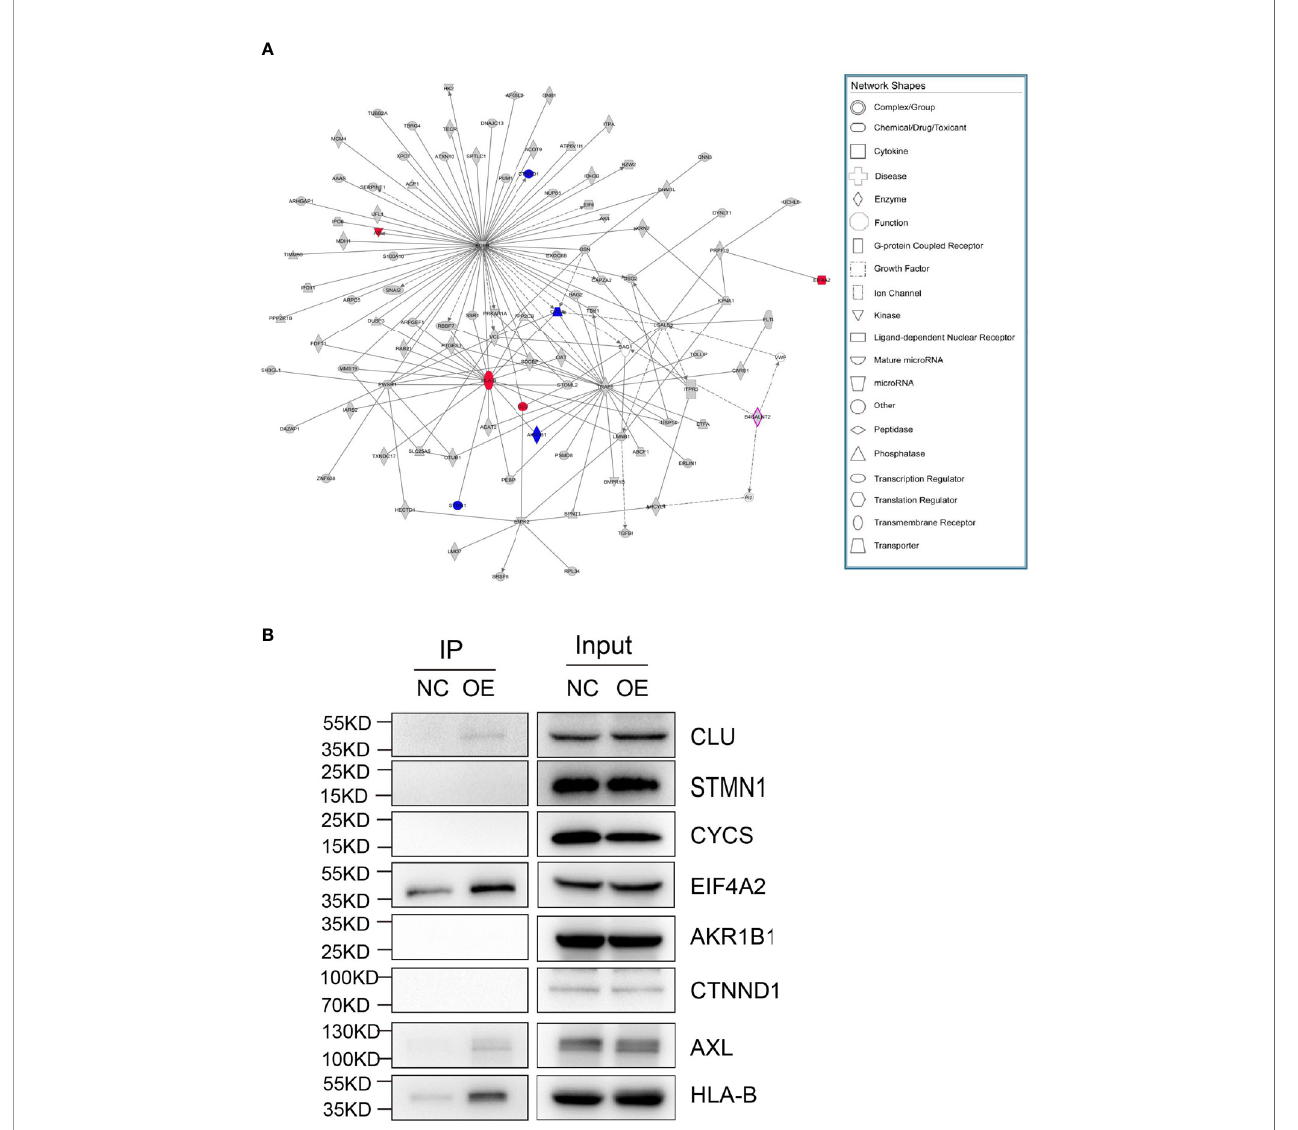
FIGURE 6 | Screening for interacting proteins. (A) The genes of the interaction proteins speci fi cally identi fi ed in the OE group were identi fi ed according to the following conditions: 1) the genes should be predicted to interact with the target gene; 2) the genes should be related to proliferation and metastasis; 3) the genes should be star genes that are reported more frequently in tumors. Such genes were analyzed for gene interaction network, and 8 candidate interacting proteins were fi nally selected for subsequent Co-IP veri fi cation experiments according to relevant literature reports. (B) Co-IP validation was performed on 8 candidate interacting proteins. Eight different proteins (CLU, STMN1, CYCS, EIF4A2, AKRIB1, CTNND1, AXL and HLA-B) were checked for their potential interaction with target gene protein, where four of them (CLU, AXL, HLA-B and EIF4A2) exhibited such feature. The gene interaction network diagram shows the interaction relationship network between molecules within a de fi ned functional region. In the network diagram, genes, proteins, chemical substances, and etc. are represented by different shapes. The gray node indicates that the gene belongs to the speci fi c gene in the experimental group, the purple node indicates that the gene is the target gene, and the colorless node indicates that the gene is the added node